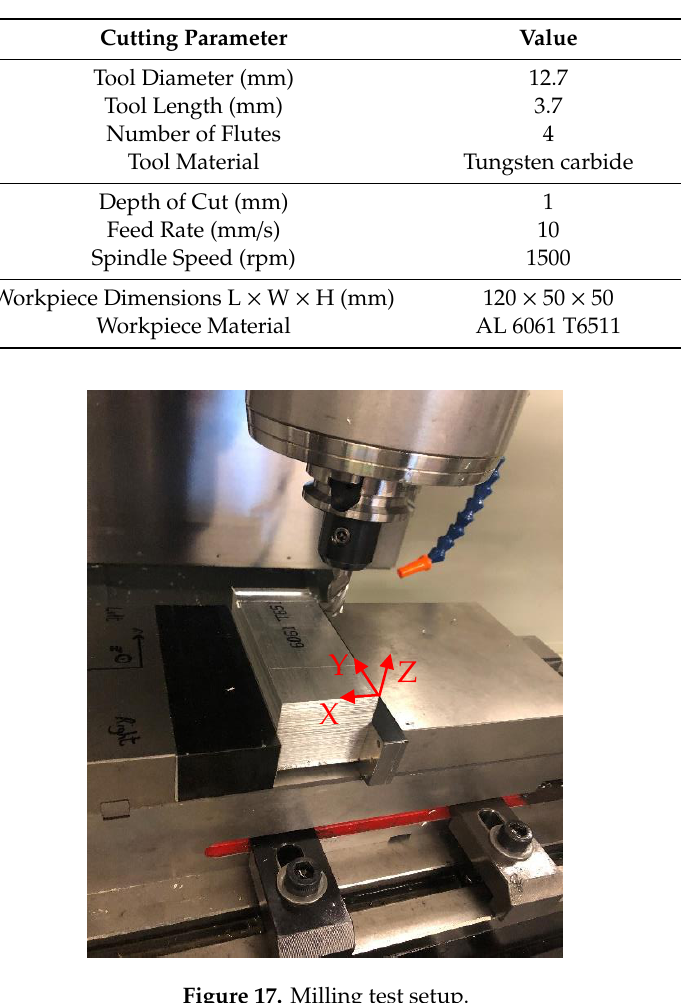
Figure 17. Milling test setup.